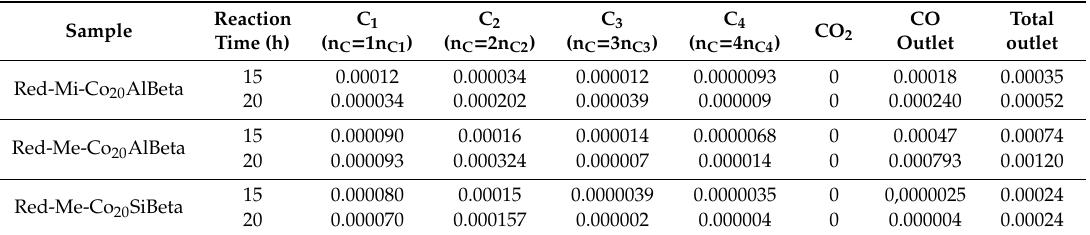
Table 4. Carbon balance for gaseous products (Carbon outlet = 0000821 mol min − 1